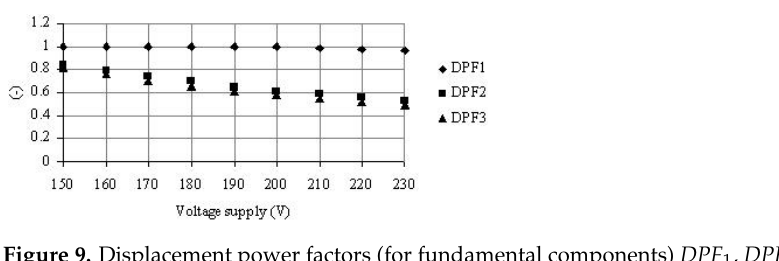
Figure 9. Displacement power factors (for fundamental components) DPF 1 , DPF 2 , and DPF 3 on each phase (a, b, c) depending on the supply voltages (set 1).